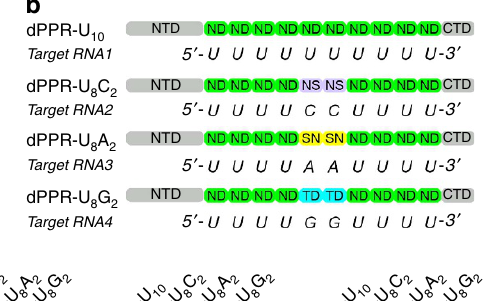
Table 1 | Statistics of data collection and refinement.